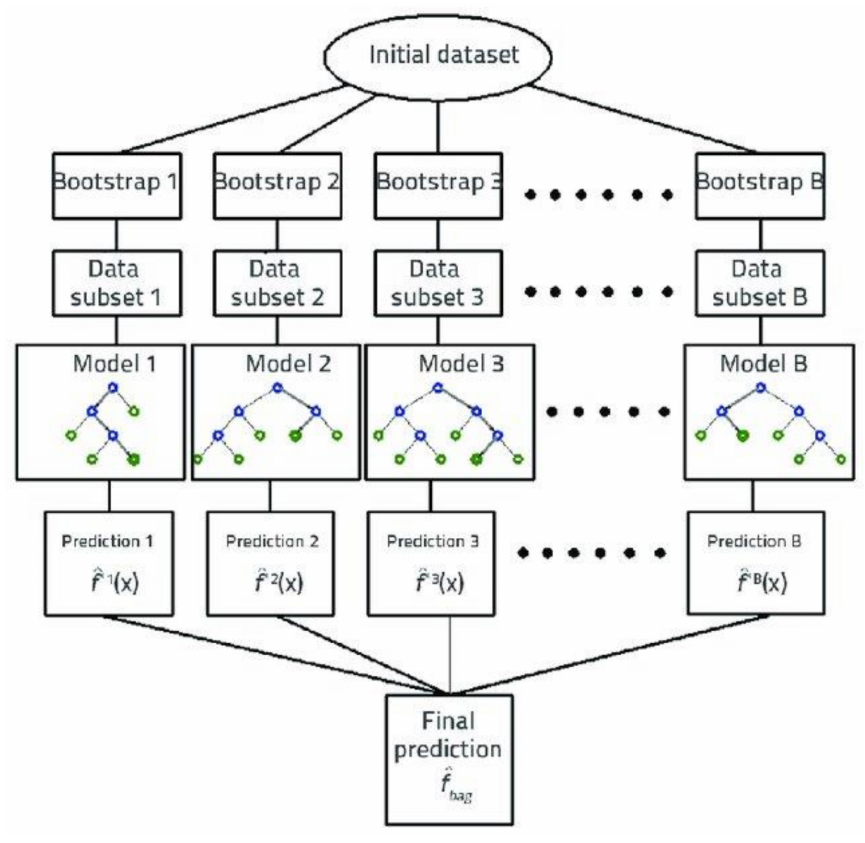
Figure 7. Bootstraps in Regression Tree Ensembles [37].